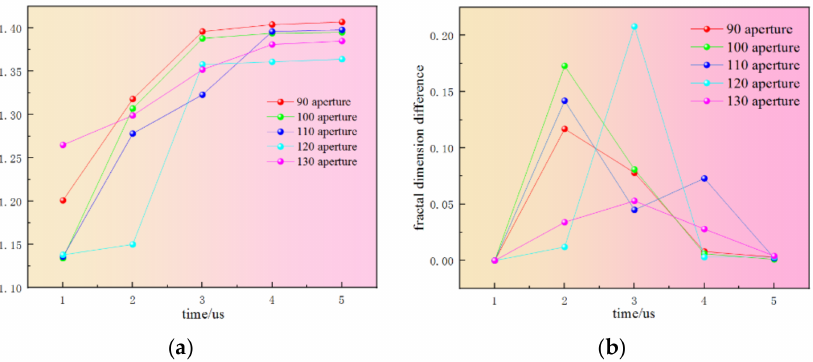
Figure 10. Variation of fractal dimension of each aperture. ( a ) Fractal dimension of each aperture; ( b ) Dimension difference of each